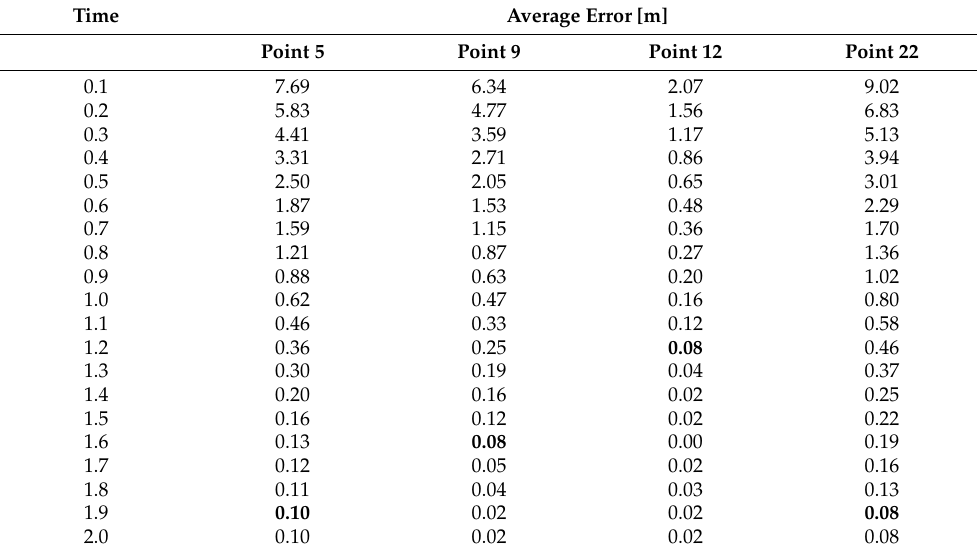
Figure 13. Error in the first 6 s (logarithmic chart). Table 6, instead, reports analytic data for each point; the values in bold refer to the time required by each point to reach an error lower than 10 cm. Table 6. Average error for each point.